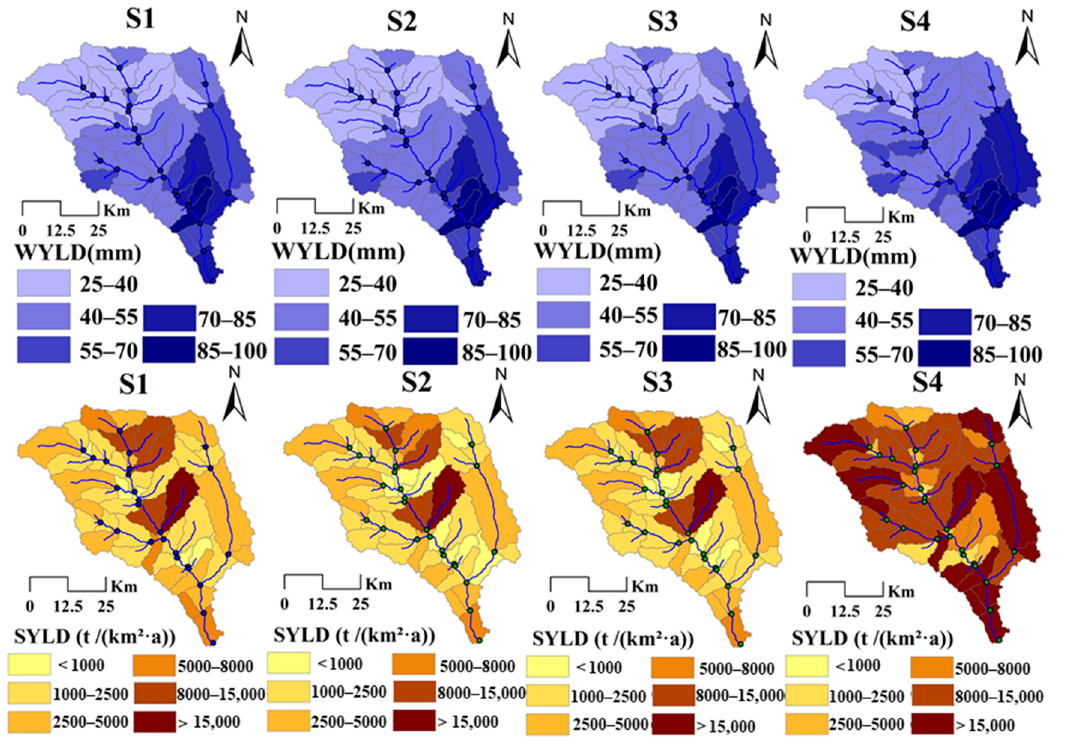
Figure 8. Spatial distribution of average annual water yield (WYLD) and sediment yield (SYLD) for four scenarios.